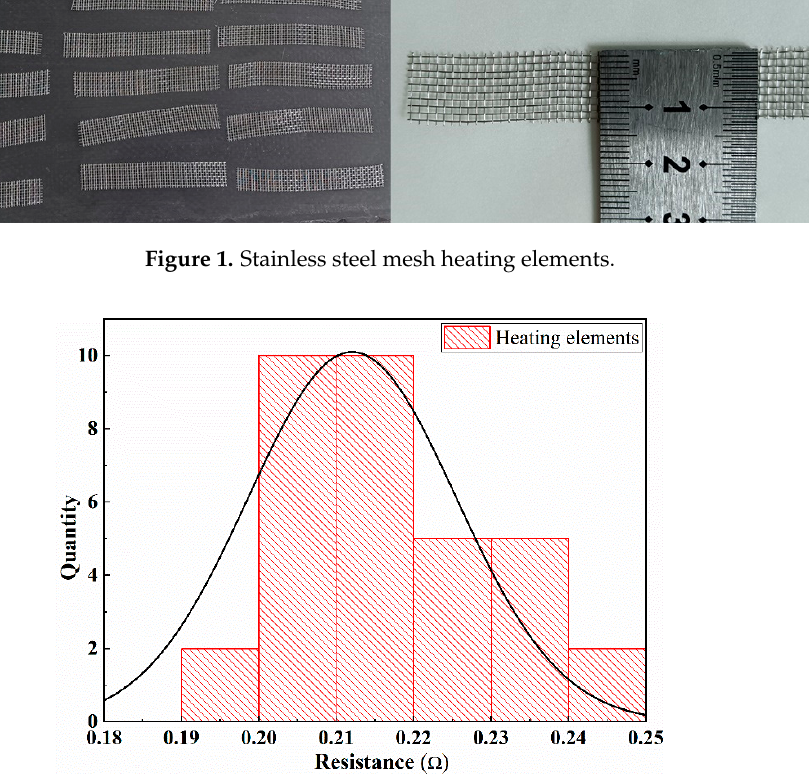
Figure 2. Resistance distribution of heating element.